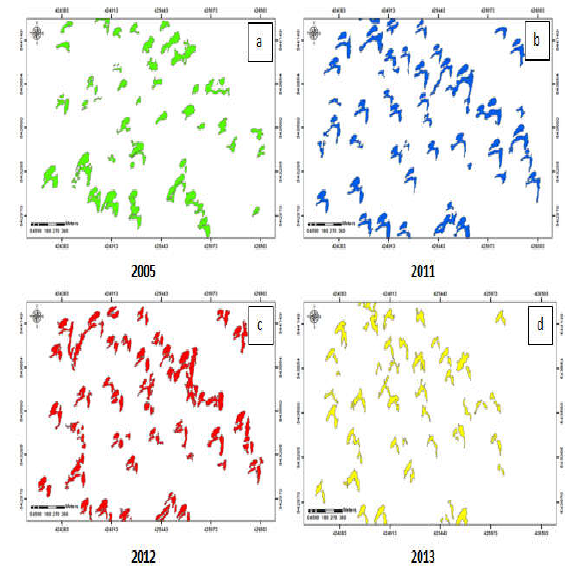
Figure 7: Aggregated dunes polygons (a 2005, b 2011,